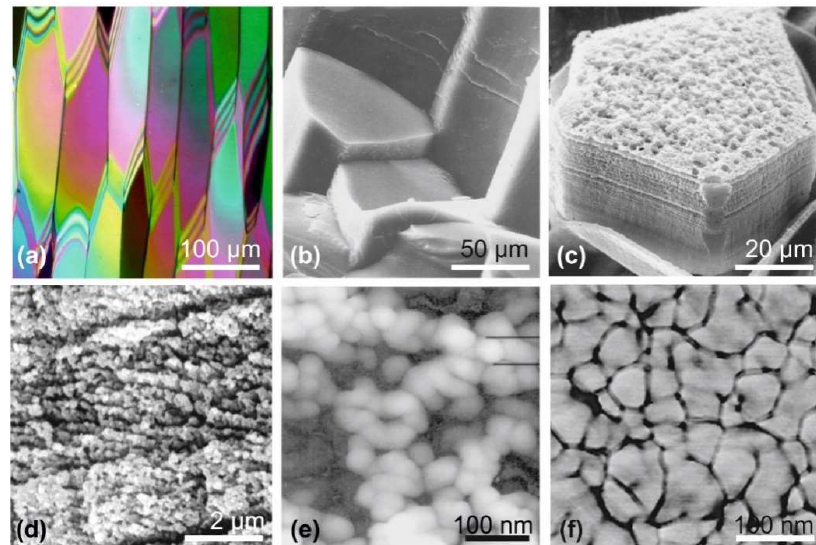
Figure 1. The earliest data on the reticulate structure of the calcareous biocrystals illustrated from Pinna shells (Pteriomorphid Bivalve). ( a ) Polarization microscopy (transmitted light) of a thin section in the prismatic structure (outer layer of the shell). Prisms are obliquely cut with respect to their growth axis. ( b ) Surface of a fractured prismatic layer. Note the perfectly compact aspect of the prismatic units consistent with polarized thin section. ( c ) Granular aspect of the growing surface of a prism whereas lateral faces show the layered mode of growth. ( d ) Evidence of the granular structure of the growth layers. ( e ) AFM view of the calcite prism ultrastructure. ( f ) Phase contrast imaging of the prism mineralized material. Credit pictures: (b,c) [15]; (d) [14].